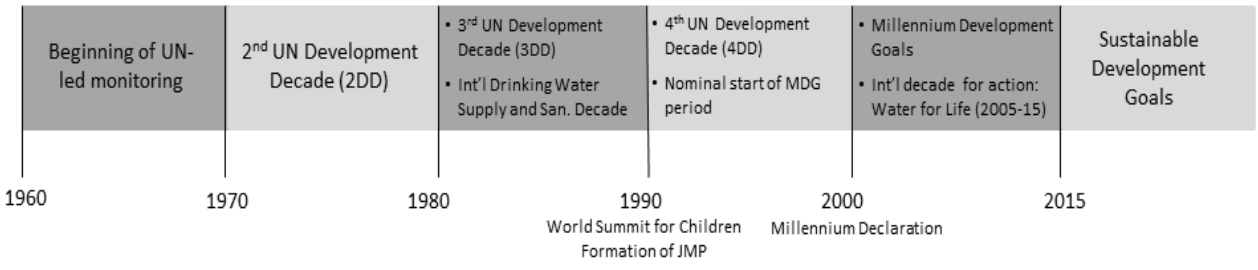
Figure 1. Timeline of international targets and actions related to drinking water and